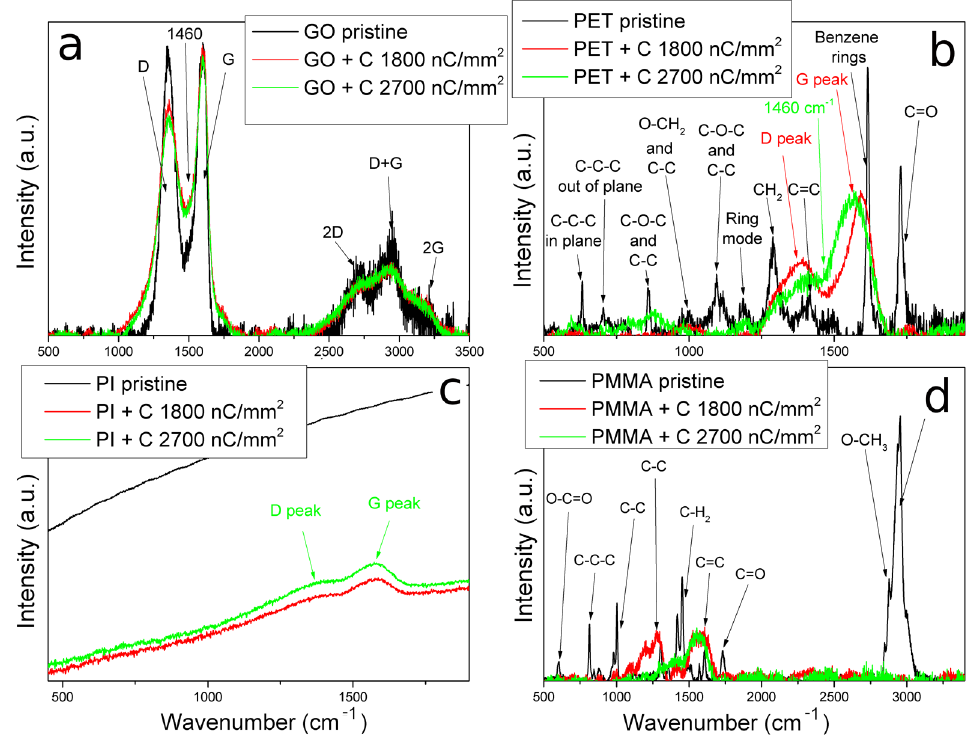
Figure 6. The Raman spectra of pristine and irradiated GO ( a ), PET ( b ), PI ( c ), and PMMA ( d ). The fluence 1800 nC/mm 2 equals 3.75 × 10 14 cm − 2 and 2700 nC/mm 2 equals 5.625 × 10 14 cm − 2 .